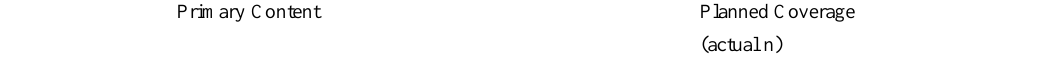
Table 3. Evaluation methods and data sources for the trans-NIH ACSI